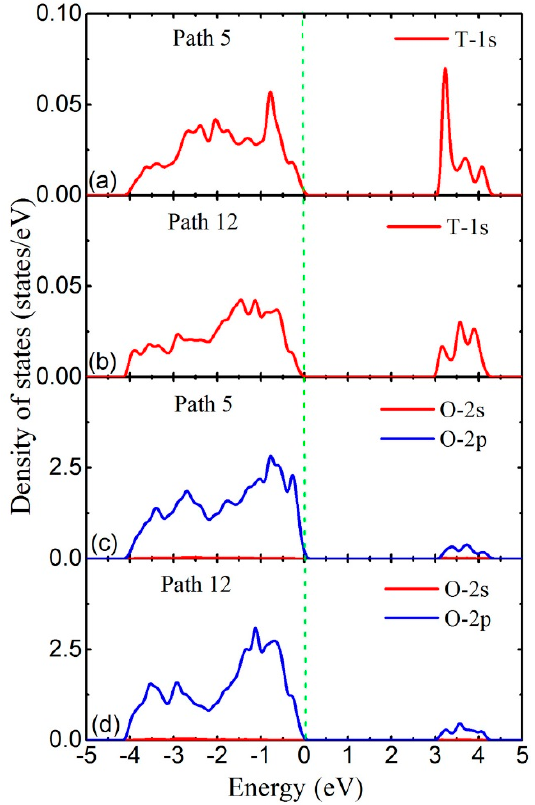
Figure 3. ( a – b ) The LDOS of tritium (T) atom with the highest energy barrier in the diffusion path 5 and path 12 (color online). ( c – d ) The LDOS of the oxygen (O) atom at both ends of diffusion path 5 and path 12. The green vertical dotted line is the Fermi level which was set to zero.